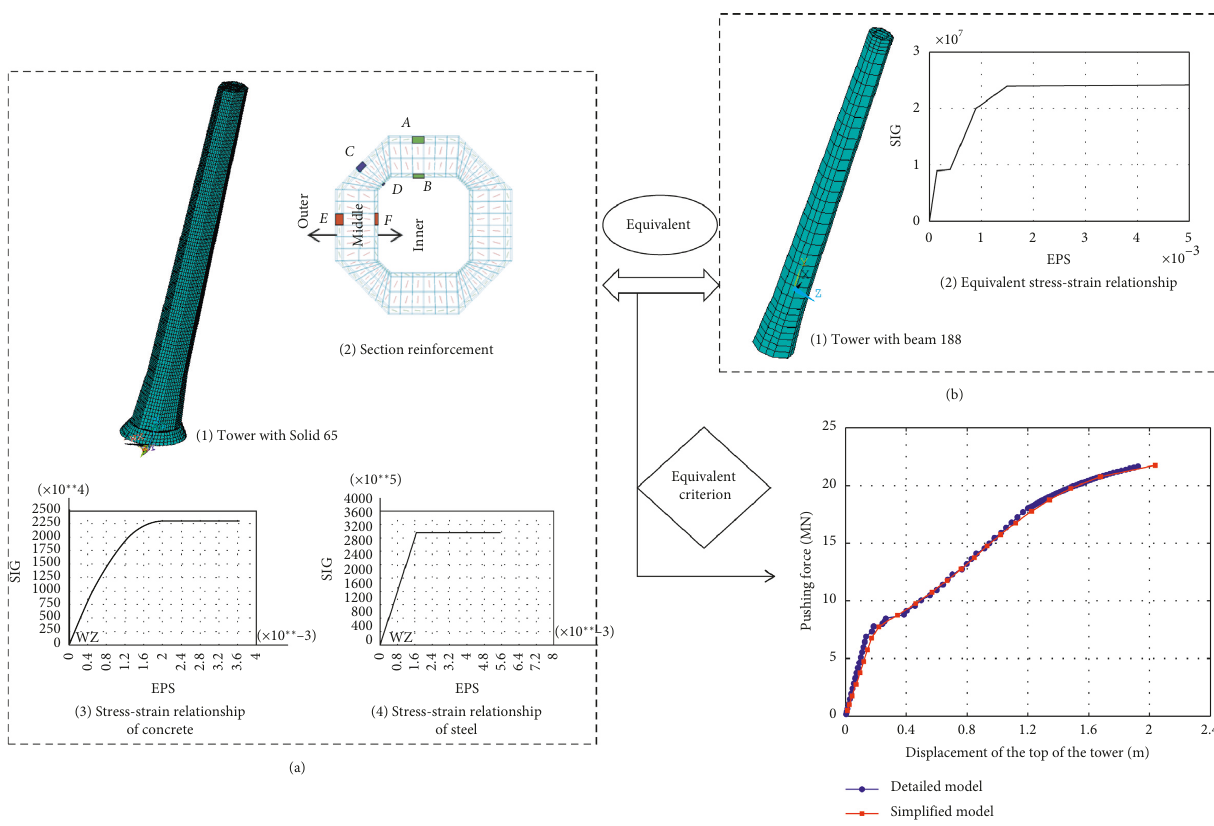
modelDisplacement of the top of the tower (m) Detailed model Simplified